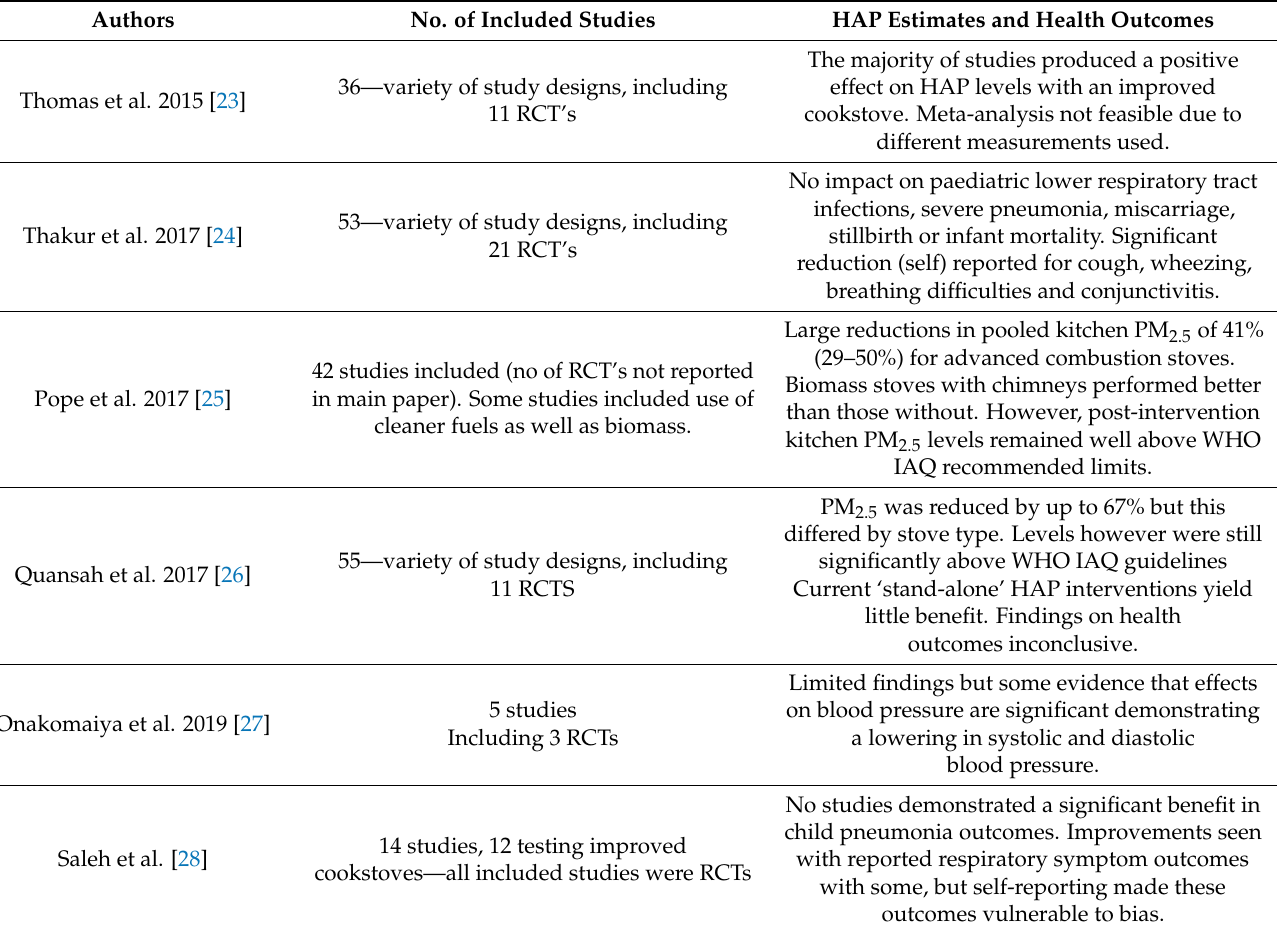
Table 2. Systematic Reviews Measuring PM 2.5 Reduction and Health Outcomes from the Use of Improved Cookstoves, that have been published since the Publication of the WHO IAQ